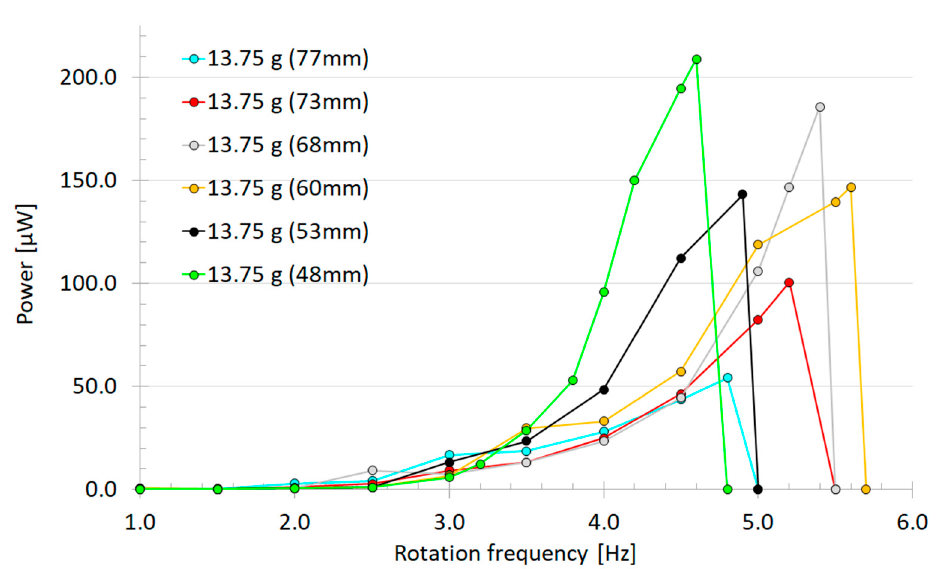
Figure 7. Harvested power as function of rotation frequency of the prototype with a 13.75 g tip mass pointed toward the center axis and measured with adjusted tip movement limiters from 48 mm to 77 mm.